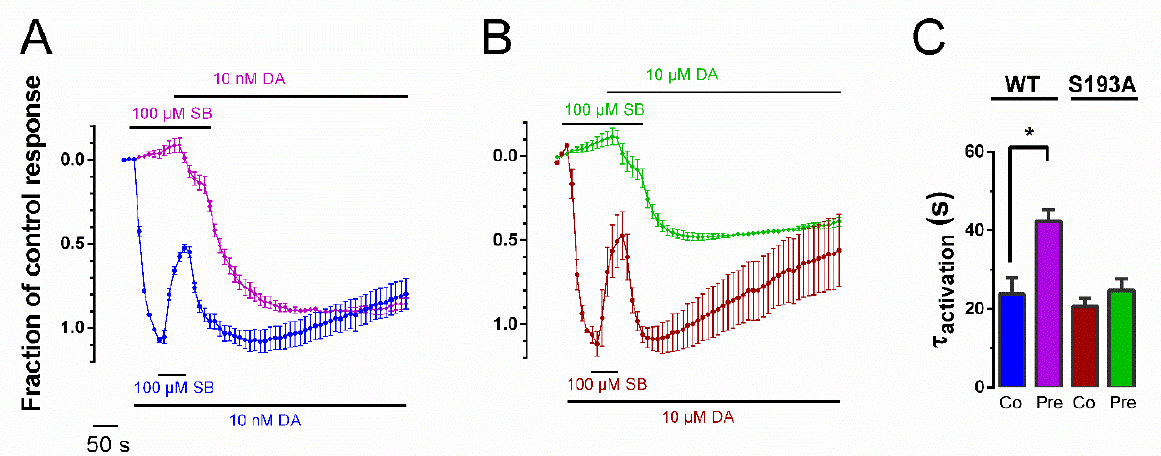
Figure 3. Pre-application slows rate of response recovery from SB269,652 modulation. ( A ) Response recovery from SB269,652 modulation at the WT D 2 R. Blue trace: 50-s application of 10 nM DA followed by 43-s co-application of 100 µ M SB269,652 with 10 nM DA and subsequent washout of SB269,652 in the continuous presence of 10 nM DA ( n = 5). Pink trace: 87 s pre-application of 100 µ M SB269,652 followed by co-application of 100 µ M SB269,652 with 10 nM DA and subsequent washout of SB269,652 in the continuous presence of 10 nM DA ( n = 3). The time course of recovery of the DA response was quantified by fitting an exponential function to the response recovery time course of individual traces during the initial 100 s after washout of SB269,652, yielding the time constant τ . Data is shown normalized to the maximal response evoked by 10 nM DA in the same cell. ( B ) Response recovery from SB269,652 modulation at the D 2 R S193A mutant under conditions corresponding to those in ( A ), with the red trace representing co-application ( n = 3) and the green trace representing pre-application ( n = 3) of SB269,652 with DA. ( C ) Mean values of τ for response recovery time courses for the pre- and co-application conditions for the WT and S193A mutant D 2 R. Asterisk indicates statistical significance for pre- and co-application conditions for the WT D 2 R: *, p ≈ 0.018, Student’s unpaired t -test. For the D 2 R S193A mutant, τ was not significantly different between pre- and co-application conditions ( p ≈ 0.330). Data are displayed as mean ± SEM.